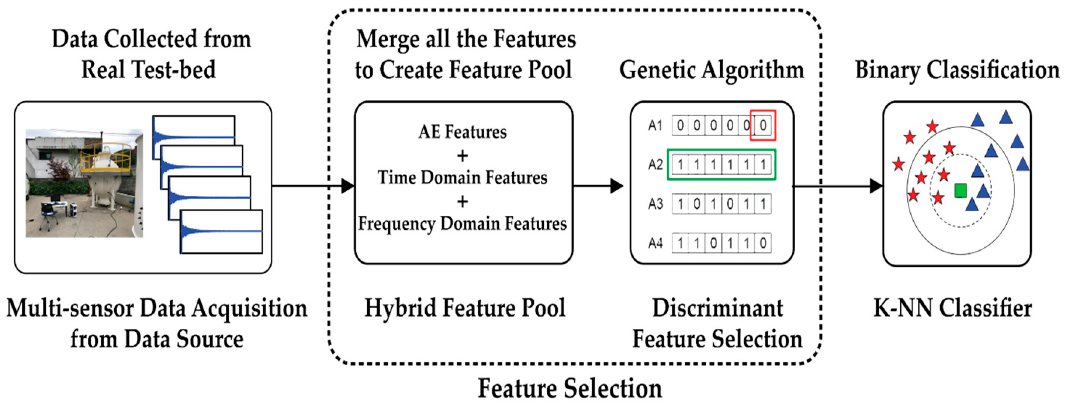
Figure 1. Block diagram of the proposed methodology.